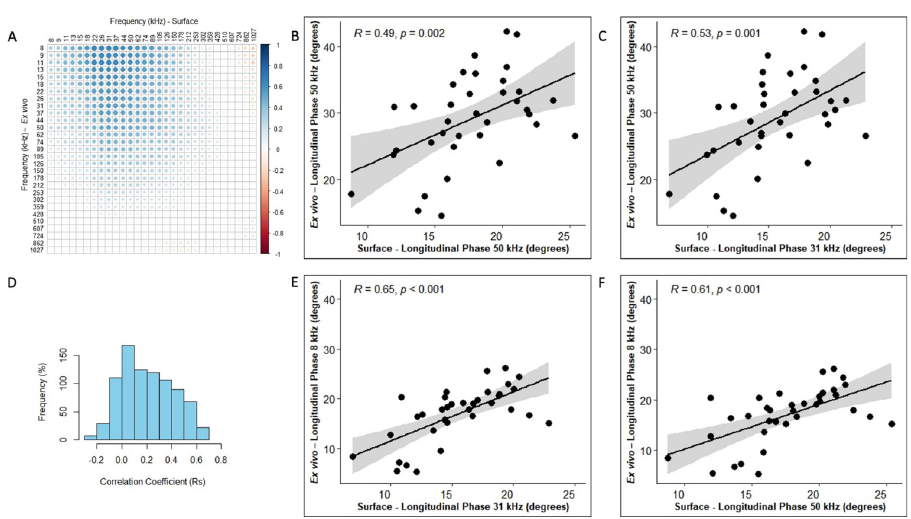
Fig 2. ALS mice data (left GA muscles) for longitudinal phase orientation (N = 36). A. Heat-map with correlation coefficients related to individual frequency spectrum on Ex vivo and Surface impedance (phase measurements, B. Linear correlation plot for 50 kHz Ex vivo and 50 kHz Surface impedance (phase) measurements, C. Linear correlation plot of surface vs ex vivo phase values at frequencies corresponding to the maximum correlation coefficient given Ex vivo impedance (phase) frequency is at 50 kHz, D. Histogram indicating the frequency of all possible correlation coefficients (Rs), E. Linear correlation plot of surface vs ex vivo phase values at frequencies corresponding to the maximum correlation coefficient within the spectrum and F. Linear correlation plot of surface vs ex vivo phase values at frequencies corresponding to the maximum correlation coefficient given Surface impedance (phase) frequency is at 50